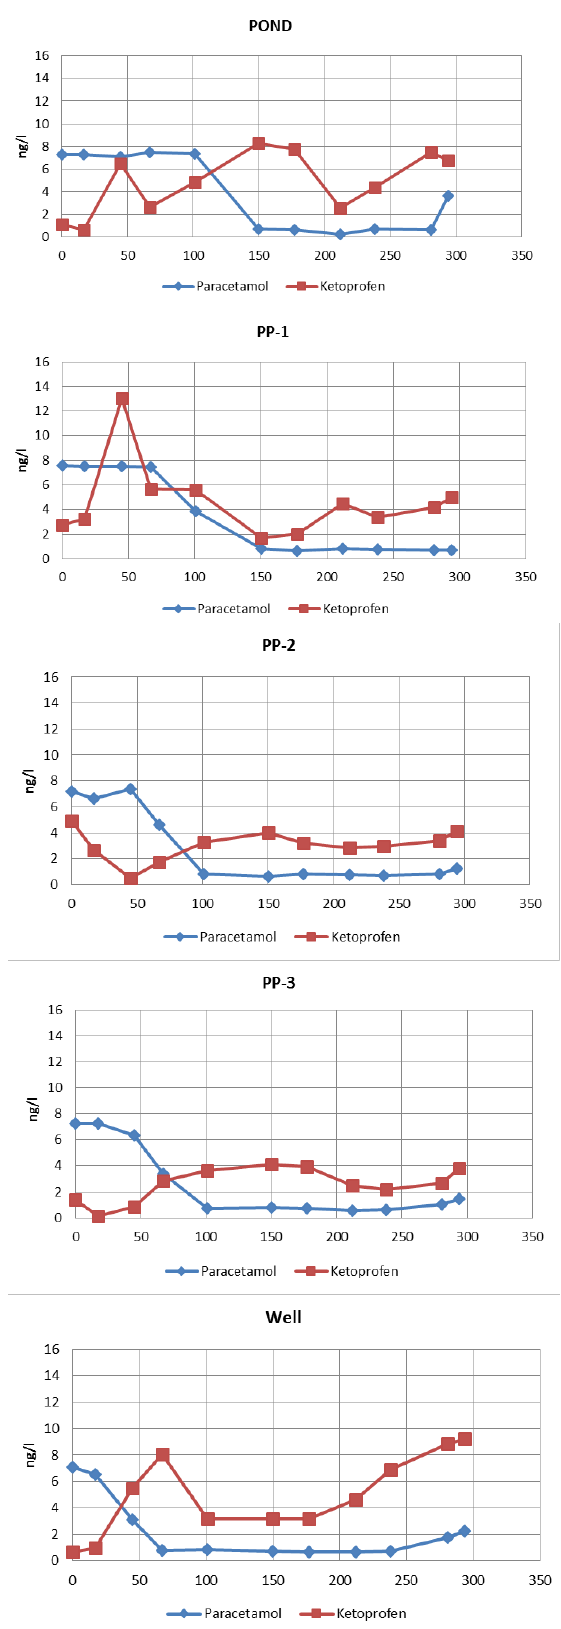
Figure 3. Concentrations of the studied pharmaceuticals in water collected from measuring points during the experiments.